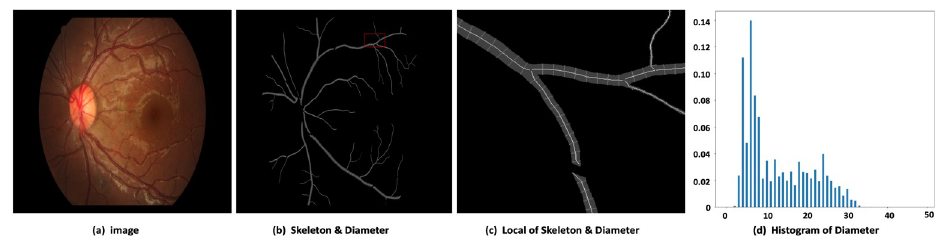
Fig 2. Visualization of the retinal vessel diameters in the fundus. (a) The raw 1880 × 2886 image. (b) Diameter of each point on the skeleton. c) Partially enlarged view of the red area in (b). (d) Histogram of the diameter map for each point on the skeleton (distance between pixels).